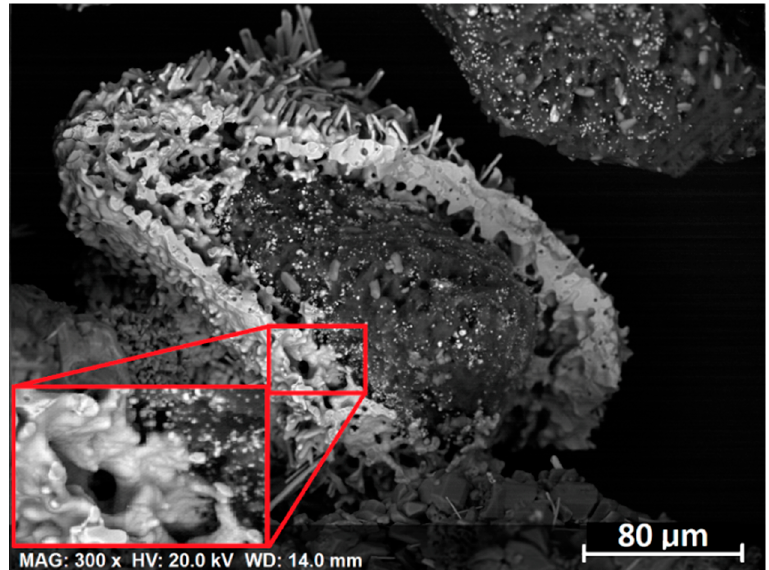
Figure 7. Fractured surface of a ferrochrome particle produced from chromite reduction by 180–300 µm charcoal, revealing the residual charcoal core with the presence of alloy nucleation on the core surface.